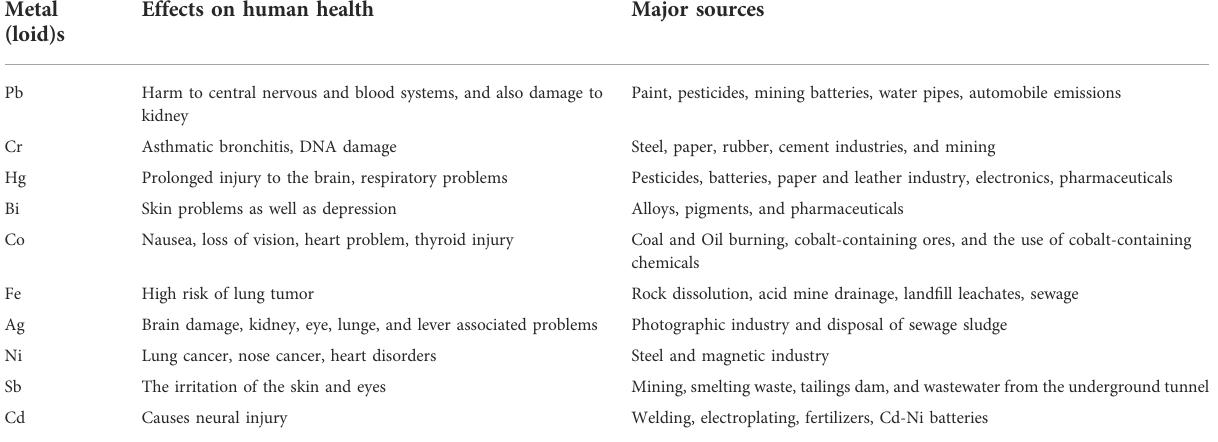
TABLE 2 Hazardous Impacts of Metal(loid)s on Human Health and their Major Sources. Metal